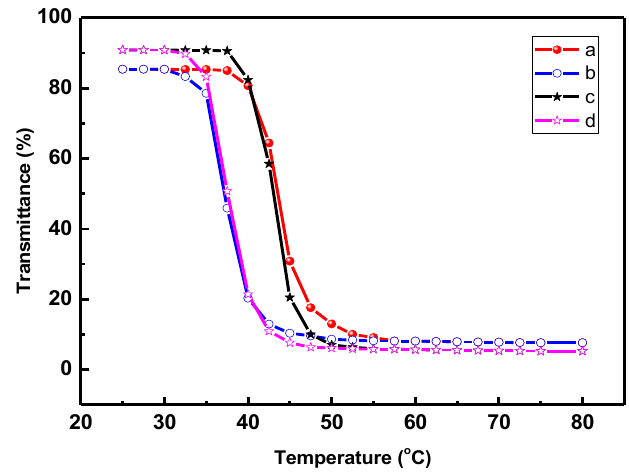
Figure 2. Variation of optical transmittance of ( a , b ) POF 10 – b– PDPAEMA 90 and ( c , d ) POF 10 – b– PDPAEMA 197 in water at a heating ( a , c )–cooling ( b , d ) cycle between 30–80 °C.